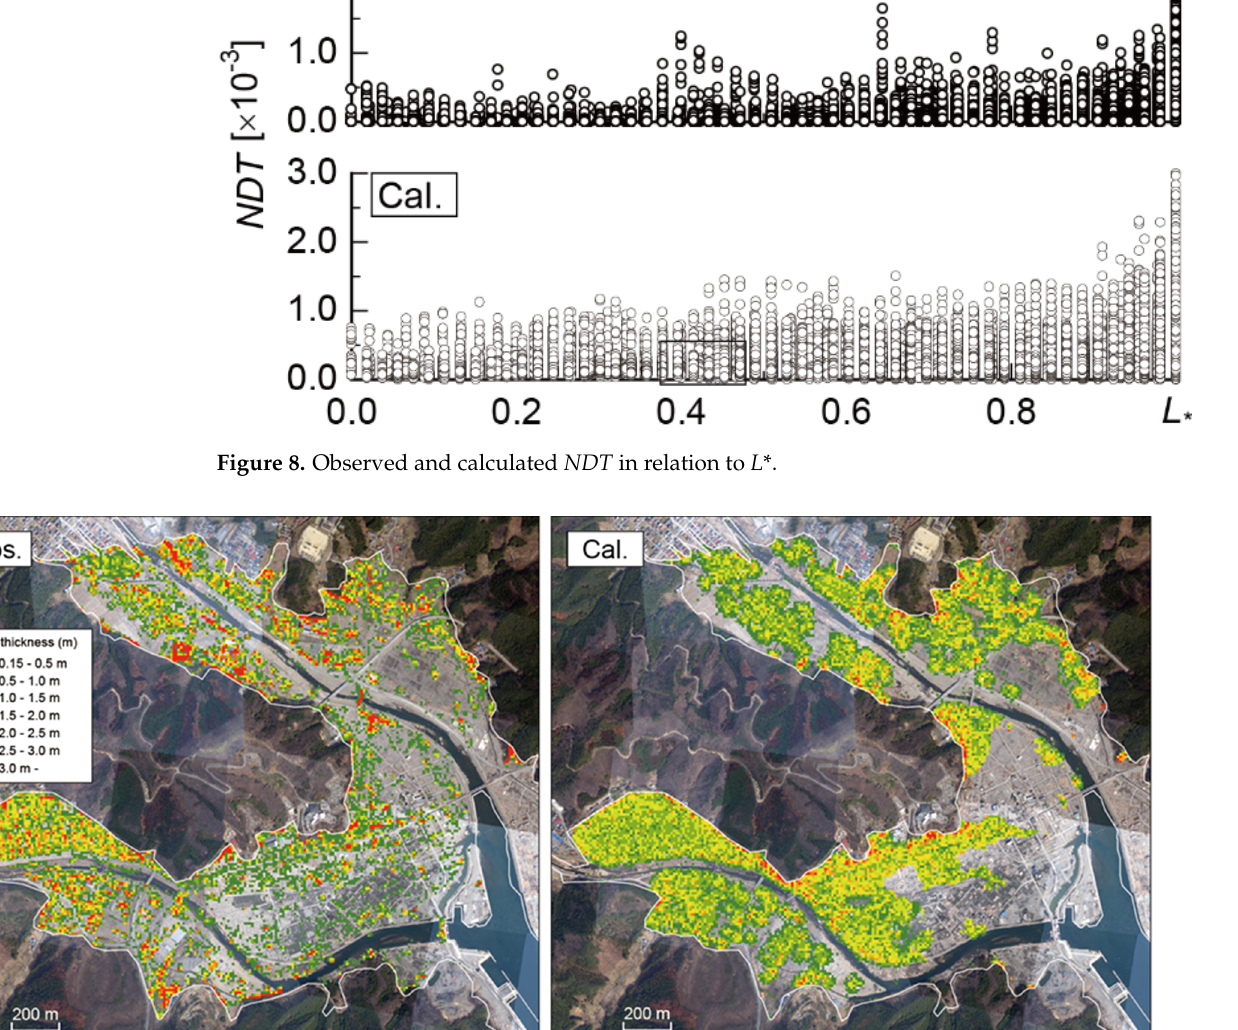
Figure 9. Observed and calculated tsunami debris accumulation thickness in Otsuchi. Each figure from Imai et al. [6]. from Imai et al.